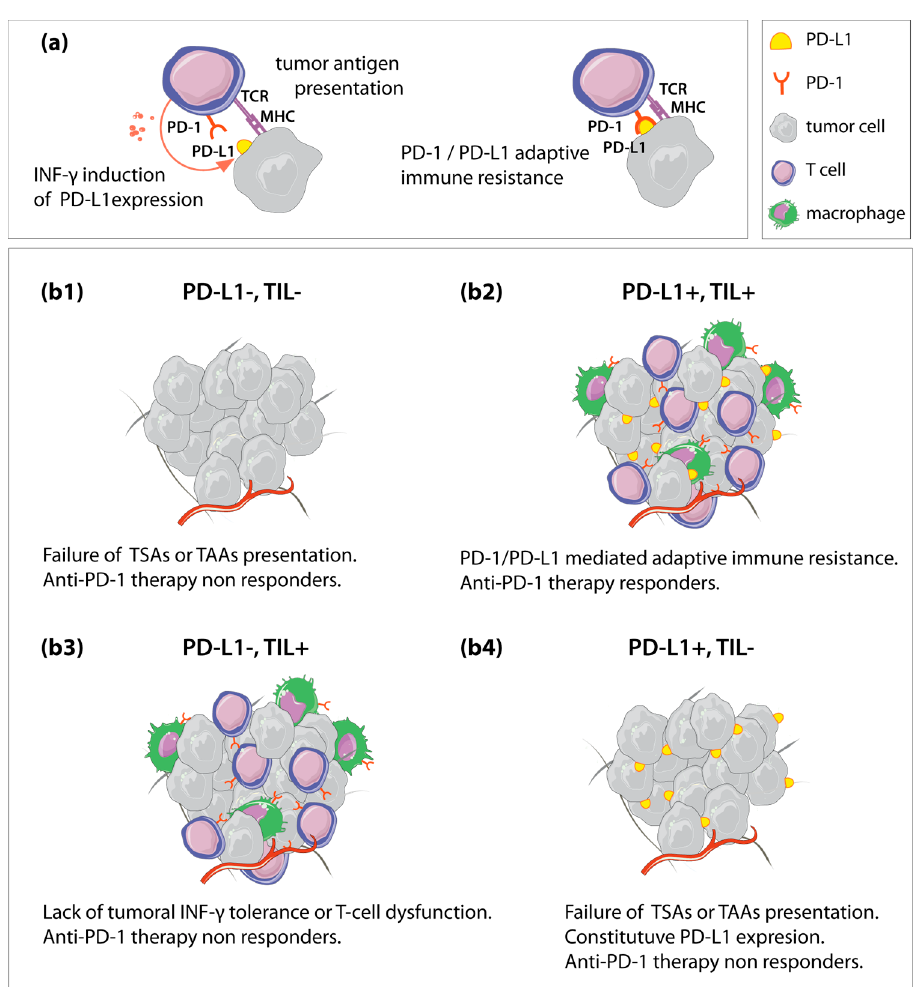
Figure 2. Schematic representation of TIME (Tumor Immune MicroEnvironment) classification. ( a ) The PD-1/PD-L1 pathway represents an adaptive immune resistance mechanism exerted by tumor cells in response to endogenous immune anti-tumor activity. Engagement of PD-L1 expressed on the tumor cells to PD-1 receptors on the activated T cells leads to inhibition of cytotoxic T cells. ( b1–b4 ) Classification into 4 subtypes listed as TIME. ( b1 ) PD-L1-, TIL − is classified into type 1 (T1). ( b2 ) PD-L1 + , TIL + , belongs to type 2 (T2). ( b3 ) PD-L1 − , TIL + belongs to type 3 (T3) and ( b4 ) PD-L1 + , TIL − , classified as type 4 (T4) although its existence is under debate. MHC: major histocompatibility complex. TCR: T cell receptor. TAAs: tumor-associated antigens. TSAs: tumor-specific antigens. Legends at the top right.